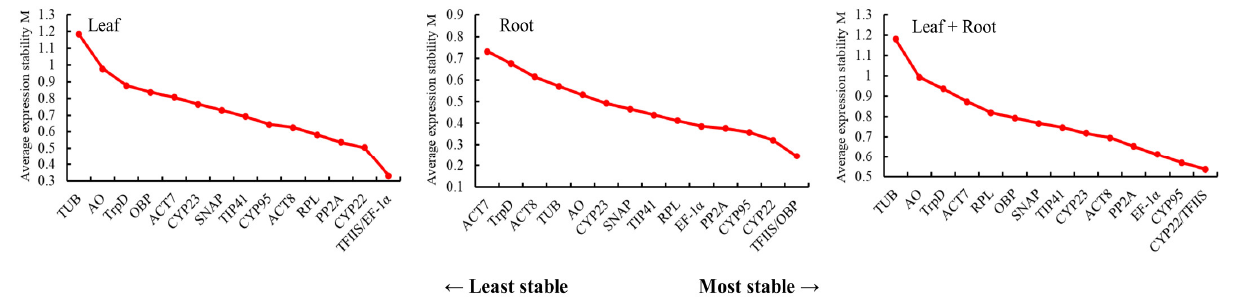
Figure 4. Average expression stability (M value) of fifteen candidate reference genes based on geNorm analyses. The most stably expressed reference genes have the lowest M values. M values were calculated for leaf, root, and leaf + root tissues of L. rotata from five habitats. Genes with M values lower than 1.5 may be used as candidate reference genes.